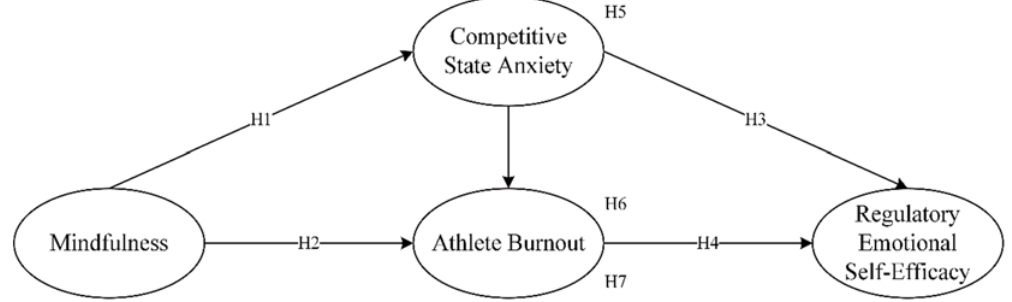
Figure 1. The hypothesized model.